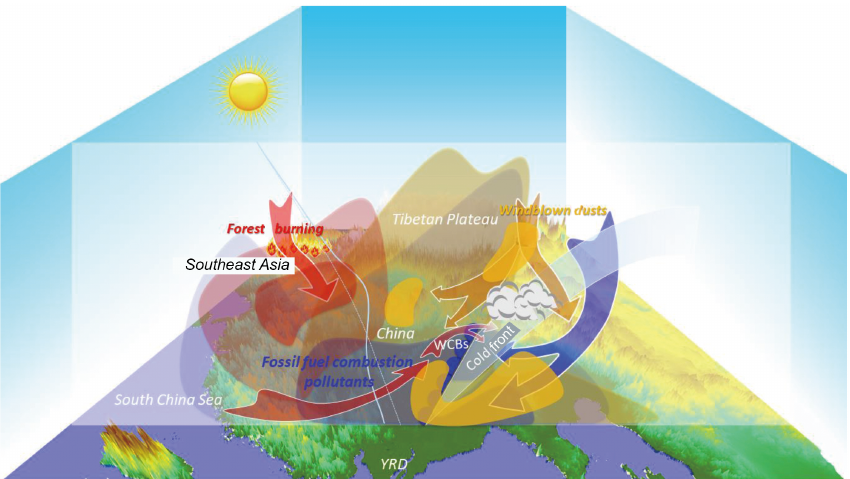
Figure 14. A schematic figure for the transport, mixing and feedback of dust, biomass burning and fossil fuel combustion pollutants in eastern